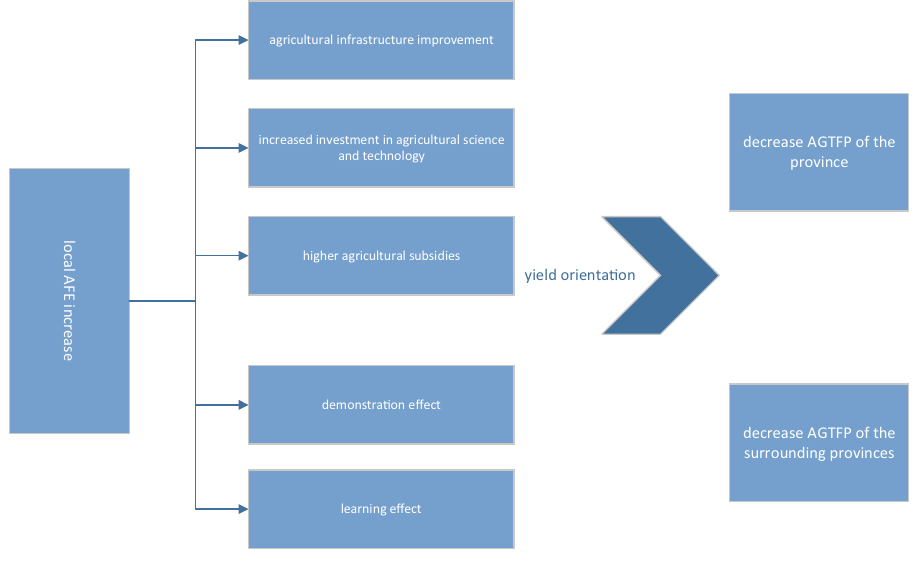
Figure 1. The transmission